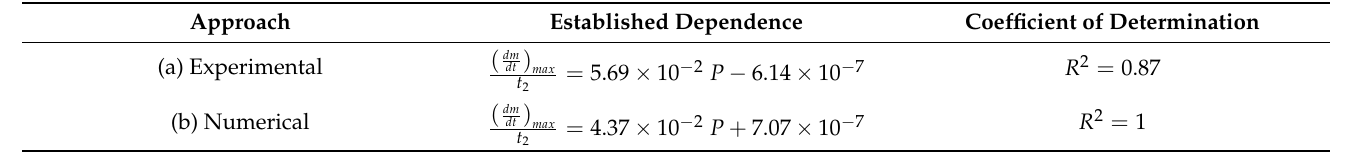
/𝑡 (cid:2870) ratio on probability of an effective collision for (a) experi- (cid:4673) (cid:3031)(cid:3047) (cid:3040)(cid:3028)(cid:3051)